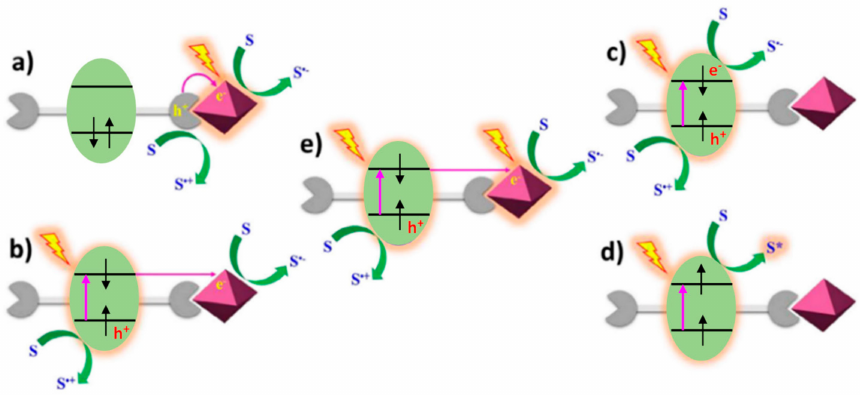
Figure 10. Schemes of photoinduced charge transfer processes occurring in photocatalytic metal-organic frameworks (MOFs): ( a ) light excitation of a node; ( b ) light excitation of a photo-active ligand (dye) in semiconductor-type MOF ( c ) Charge transfer and ( d ) Energy transfer processes in dye active MOFs; ( e ) dual excitation phenomena in the presence of semiconductor nodes and photoactive dye molecules into the same MOF [1], Copyright (2019)